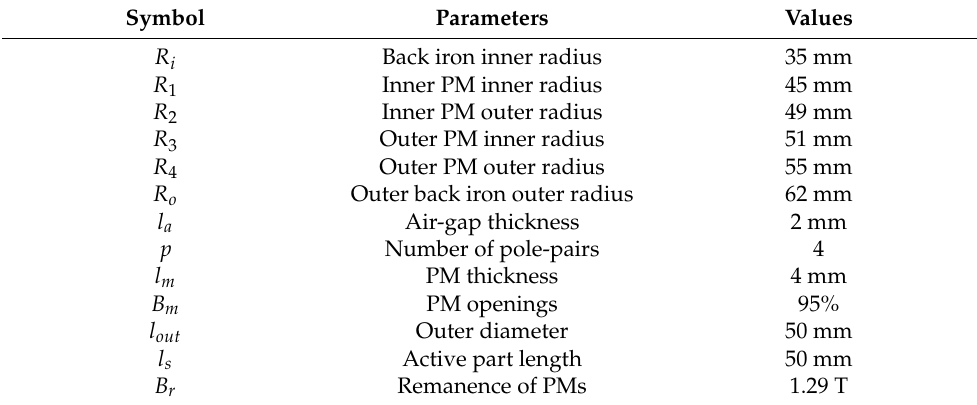
Figure 1. Outline of the CMC. Table 1. CMC parameters used in the validation exercise.